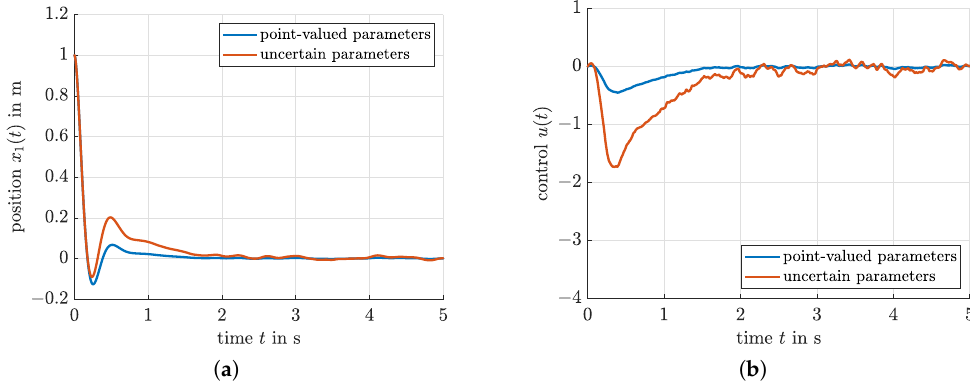
Figure 5. Control performance of the proposed iterative LMI-based optimization technique. ( a ) Position x 1 for the spring-mass-damper system. ( b ) Control signal u for the spring-mass-damper system.